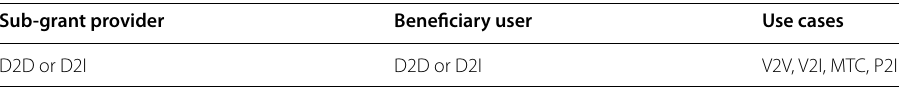
Table 1 Different scenarios of the sub‑granting scheme Sub-grant